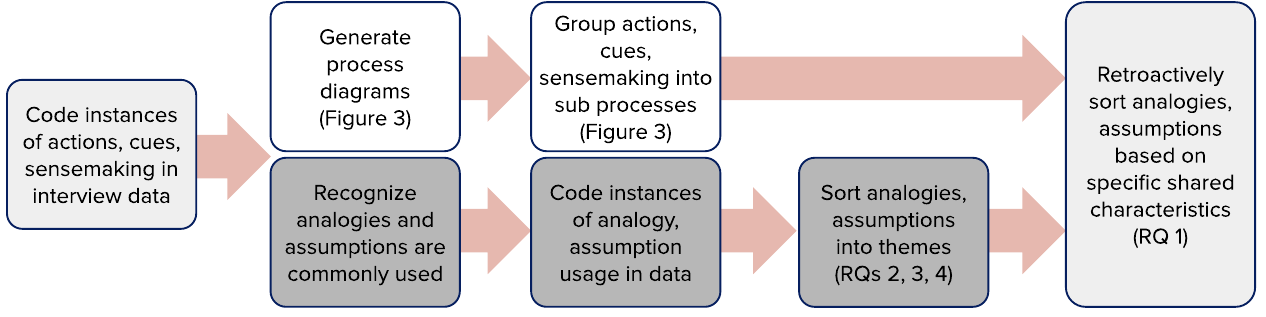
FIG. 2. A flowchart summarizing the rounds of analysis performed on the interview data.